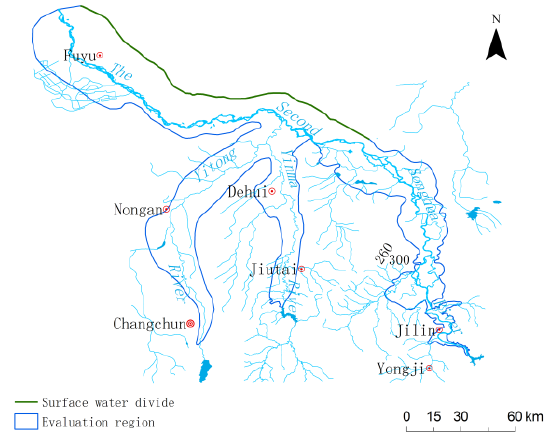
Figure 5. The core study area for evaluating RBF site suitability.